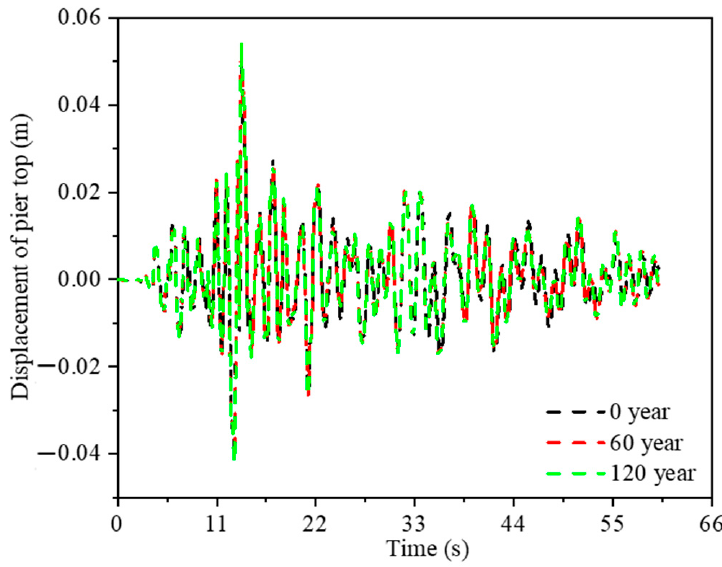
Figure 18. Time history curve of 2# pier top displacement under LRB performance degradation.